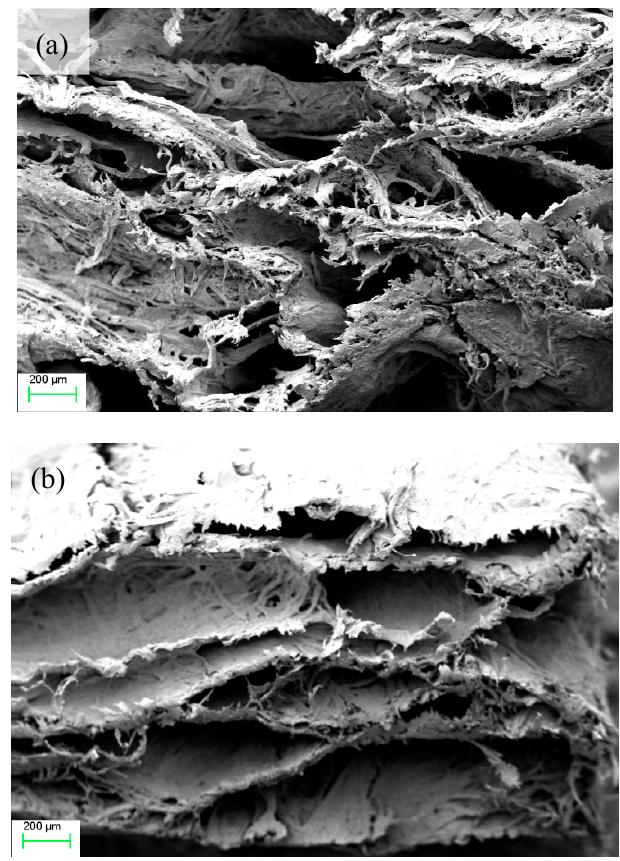
Figure 10. The SEM image of MMT ( a ) and OMMT ( b ).